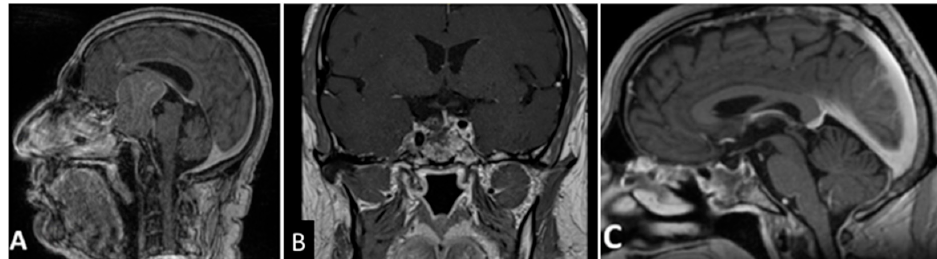
Figure 1. T1- weighted contrast-enhanced MR images. Preoperative sagittal ( A ) view showing a giant pituitary macroadenoma, Knosp grade 1. Three-month postoperative coronal ( B ) and sagittal ( C ) views showing GTR. GTR: gross total